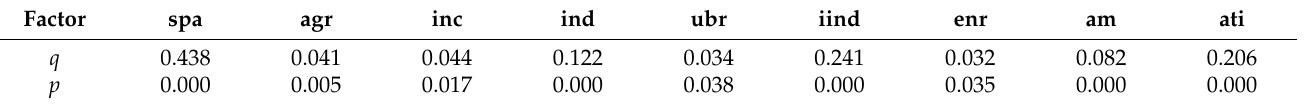
Table 4. Detection results of influencing factors of agricultural methane emissions in China.